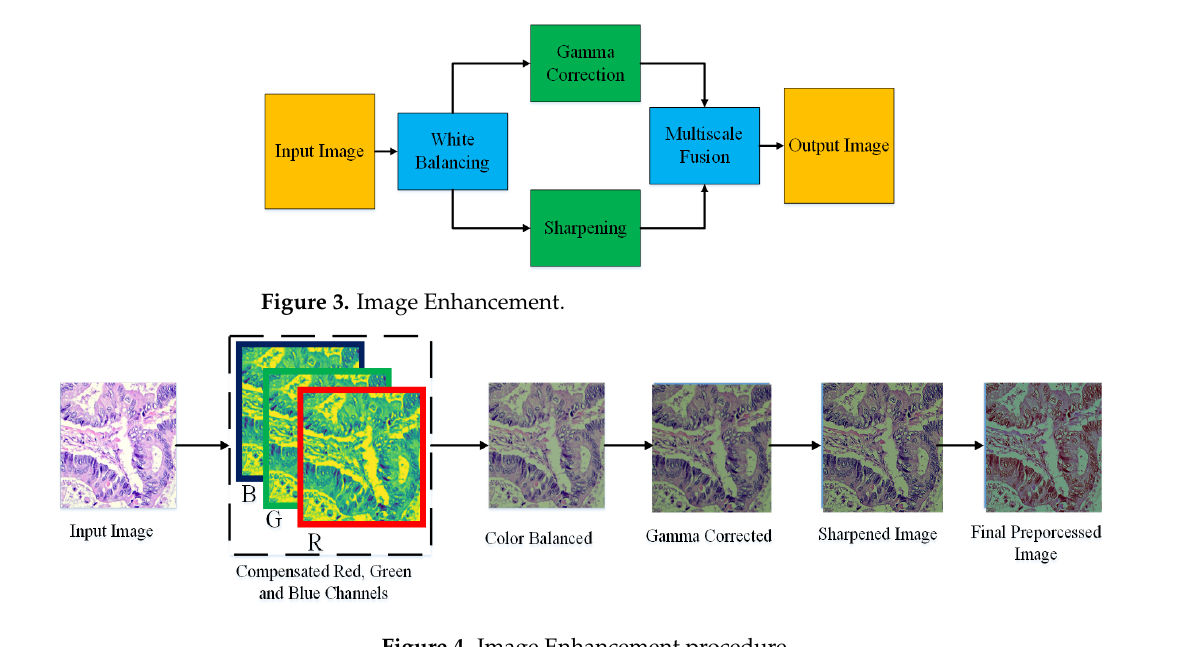
Figure 4. Image Enhancement